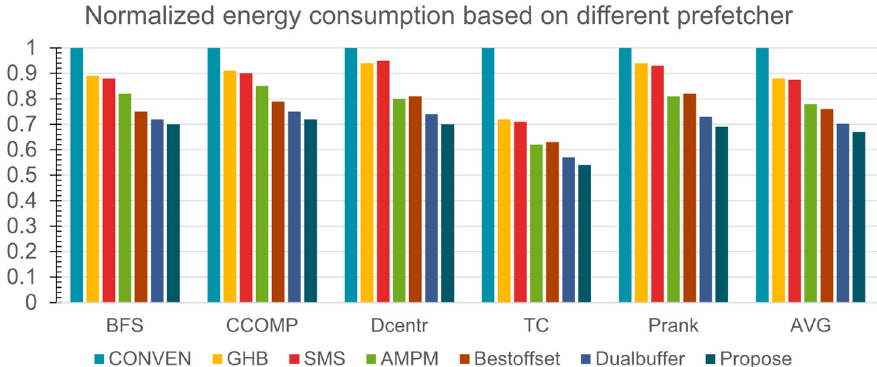
Figure 12. Energy consumption for graph processing.